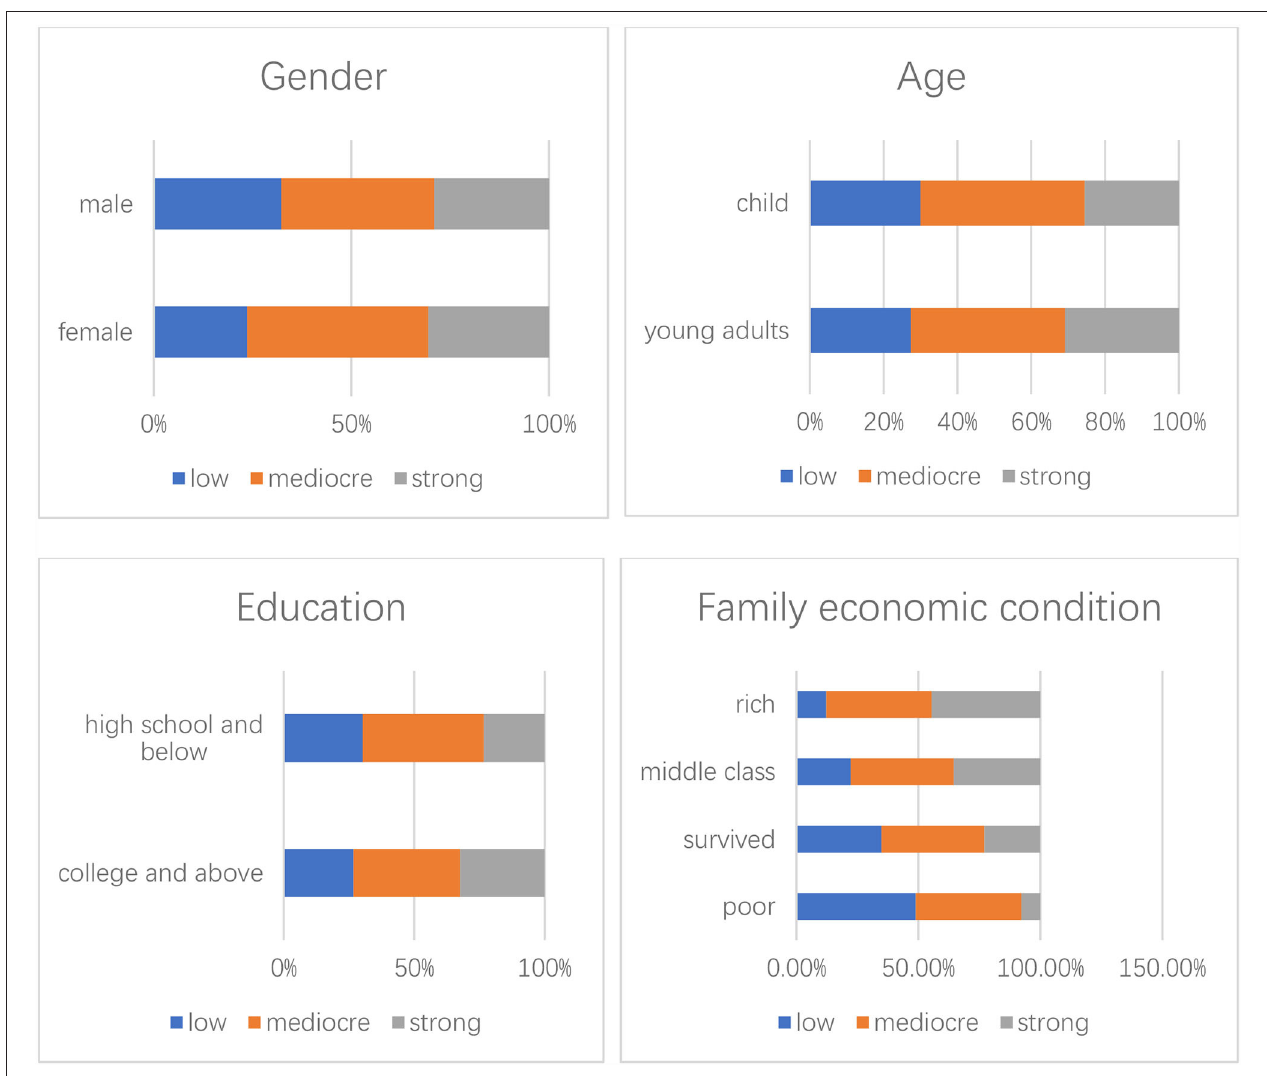
FIGURE 8 | Profile of fandom publics among young